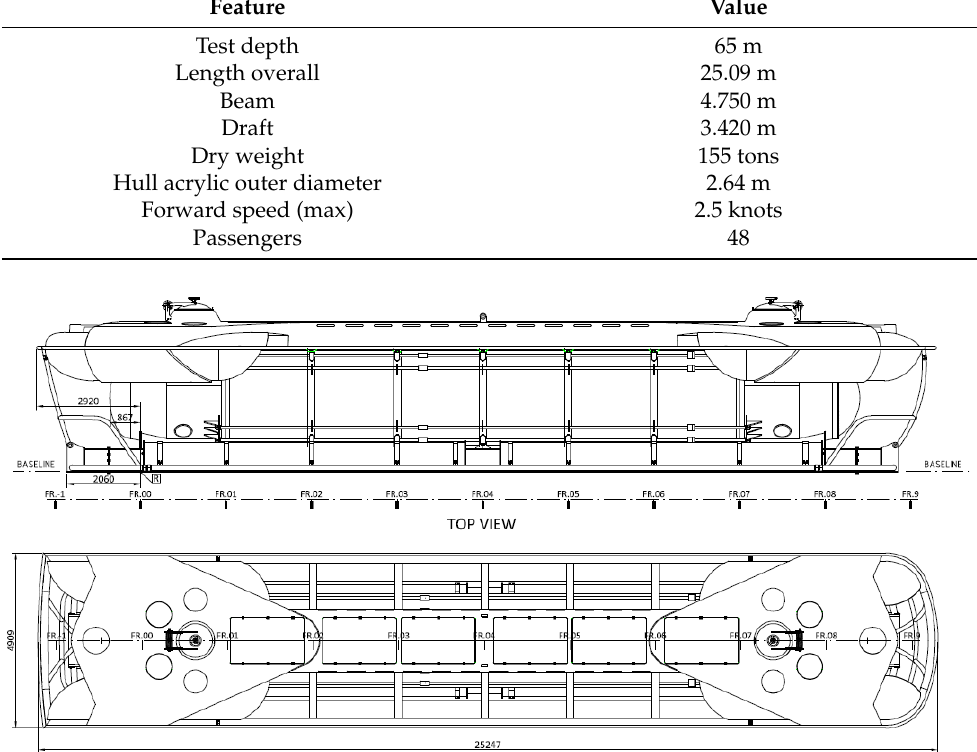
Figure 2. General view of the transparent acrylic submersible